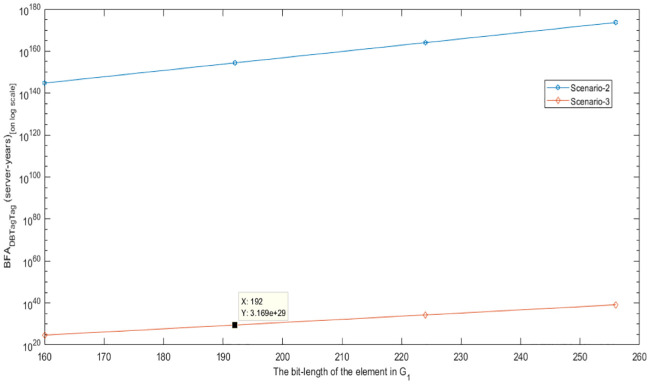
BFADBTagTag cost: Scenarios-2 vs Scenarios-3 (LMappingSecretKey = 160 bits).